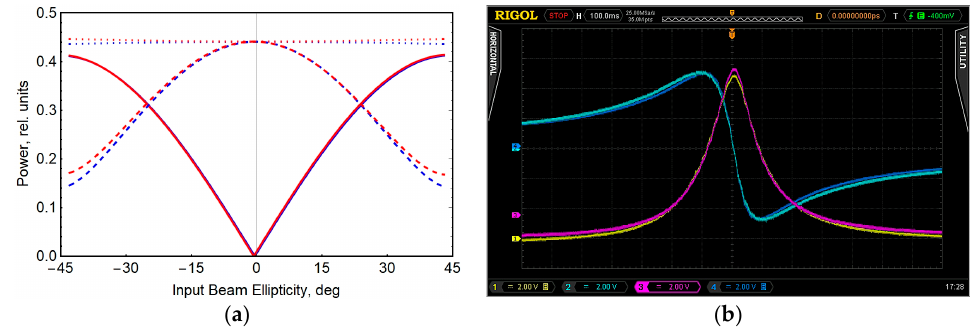
Figure 2. ( a ) Example of calculation results: red lines are the light intensity at the input to cell C1, and blue lines are the light intensity at the input to cell C2. Solid lines are the circular component; dashed lines are the linear component; dotted lines are the total intensity. ( b ) Oscillograms of the magnetic resonance signals in cells C1 and C2 after synchronous detection (one component and MR signal module are shown).